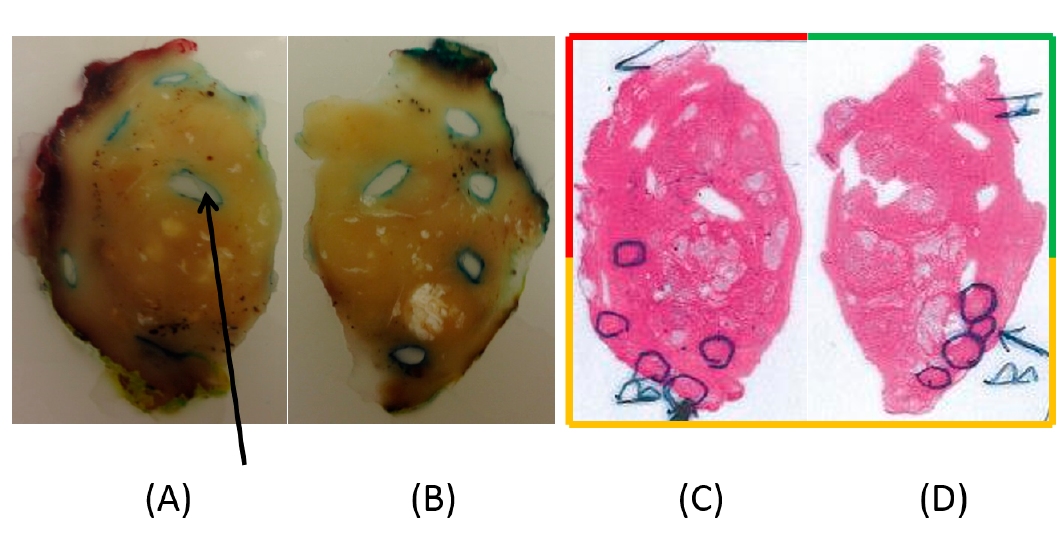
Figure 10. ( A , B ) Photographs of slices of the left and right sides of P-1, embedded in paraffin; ( C , D ) Scans of the corresponding photomicrographs. The original diameter of P-1 was 50 mm. Multiple areas of dorsal parts of the prostate identified as tumor tissue with a Gleason score of 6 (3 + 3) are marked with circles. The arrow in ( A ) shows one of the punch holes where tissue was removed after the stiffness analysis for further pathological assessments. In ( A , B ), the periphery of the sliced tissue shows traces of the red, green, and yellow staining of the surface made by the pathologist. The frame surrounding ( C , D ) is colored red, green, and yellow correspondingly.